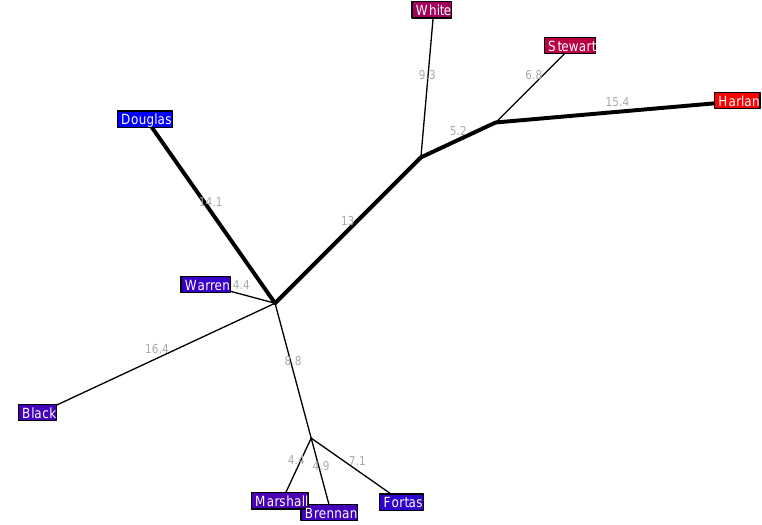
Figure 9. Judicial tree for the 1967–1969 Warren 10